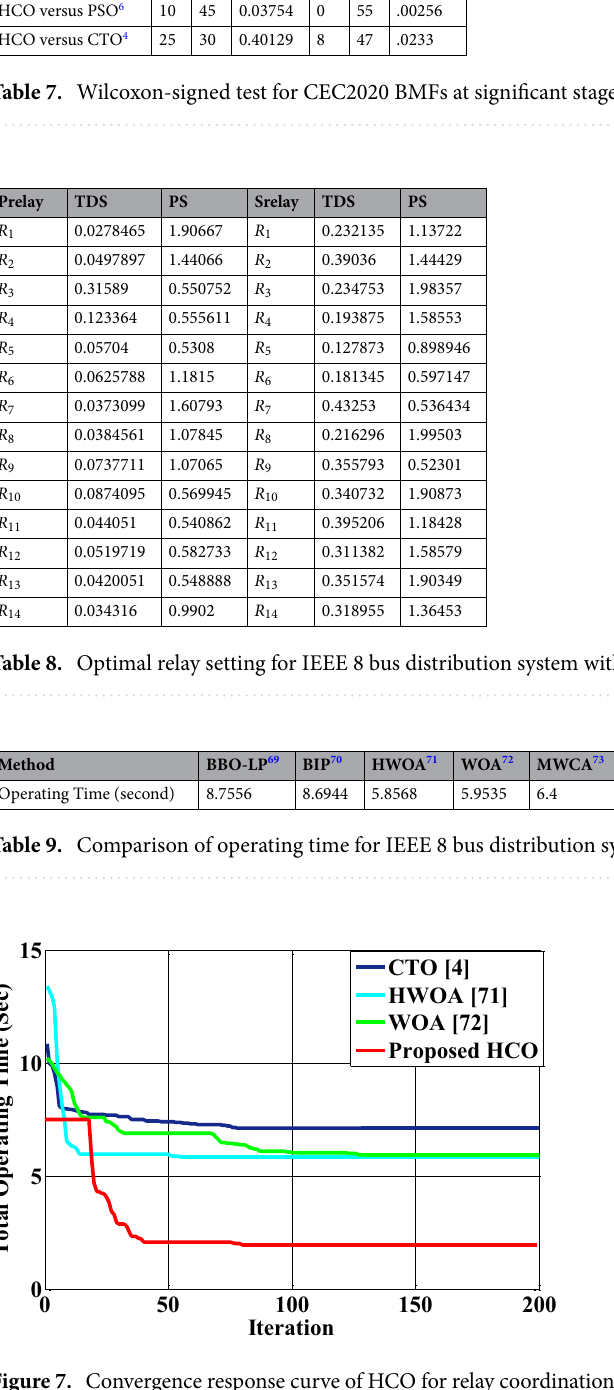
Figure 7. Convergence response curve of HCO for relay coordination